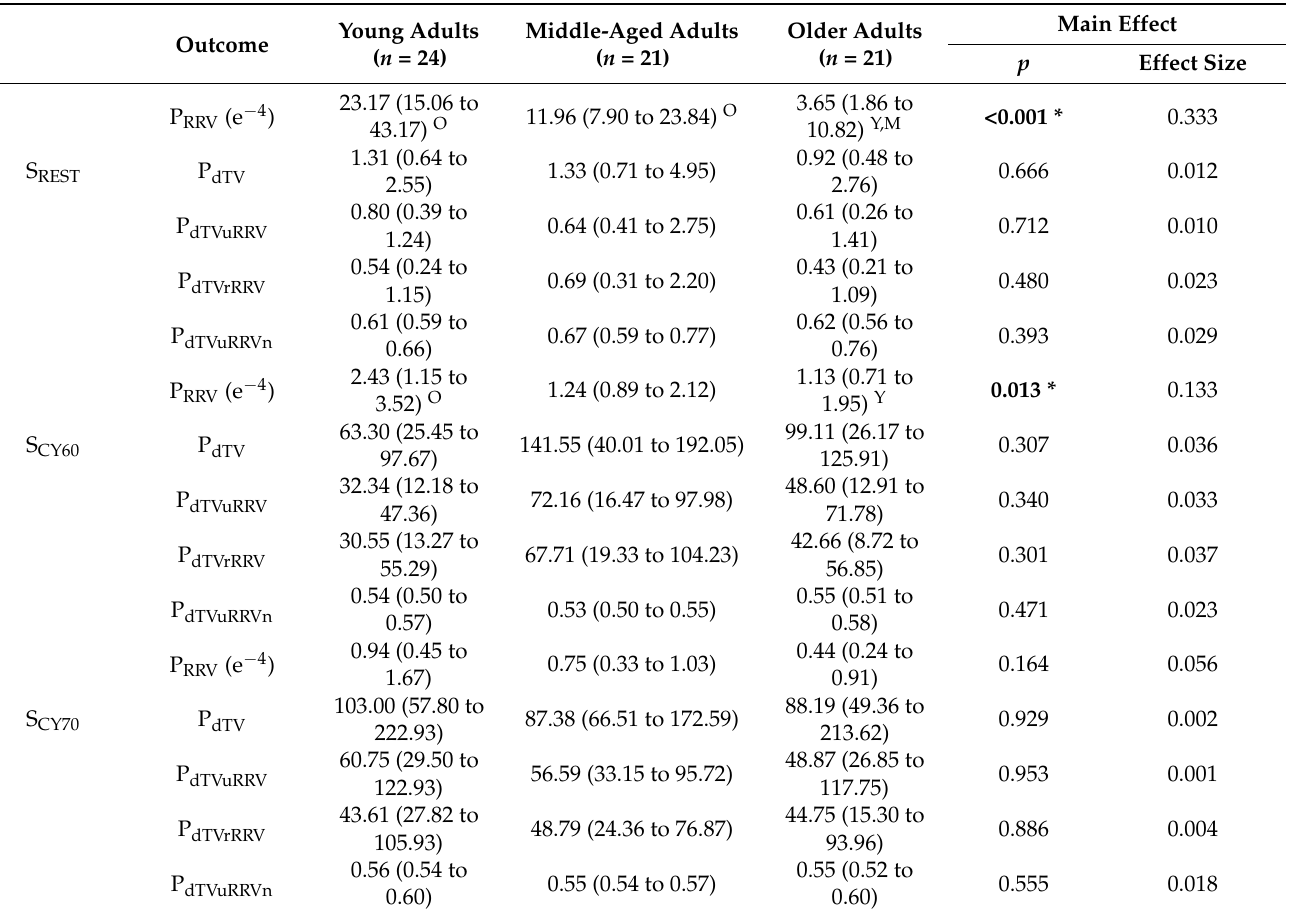
Table A1. Comparison of P RRV , P dTV , P dTVuRRV , P dTVrRRV and P dTVuRRVn between age groups at the different evaluated test